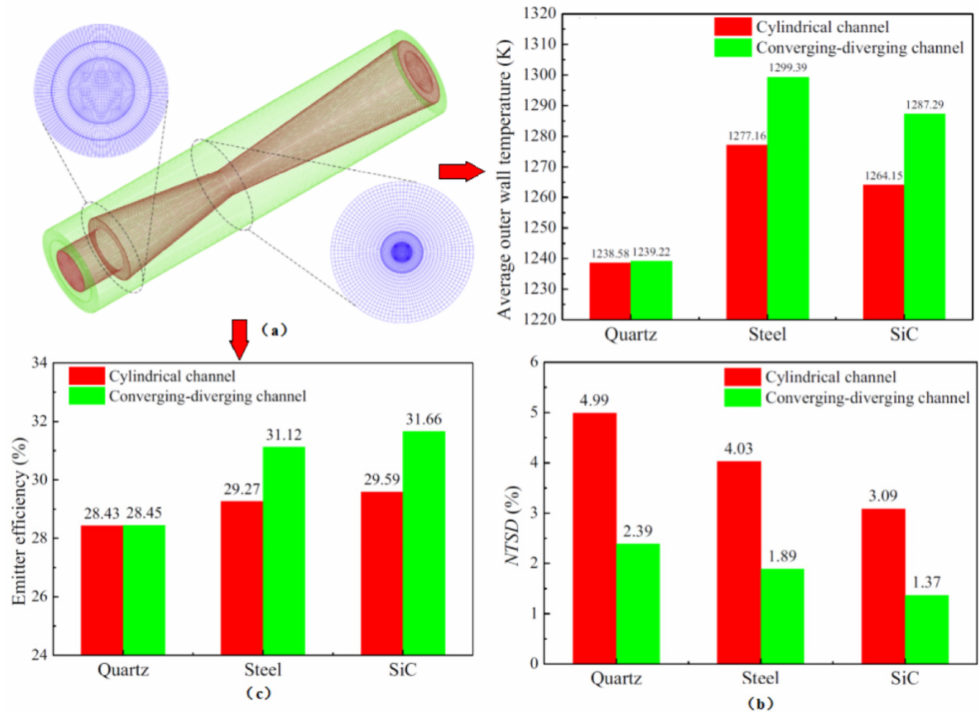
Figure 11. Emitter efficiency, wall temperature and NTSD of combustor [84], ( a ) Combustor grids, ( b ) Wall temperature and NTSD, ( c ) Emitter